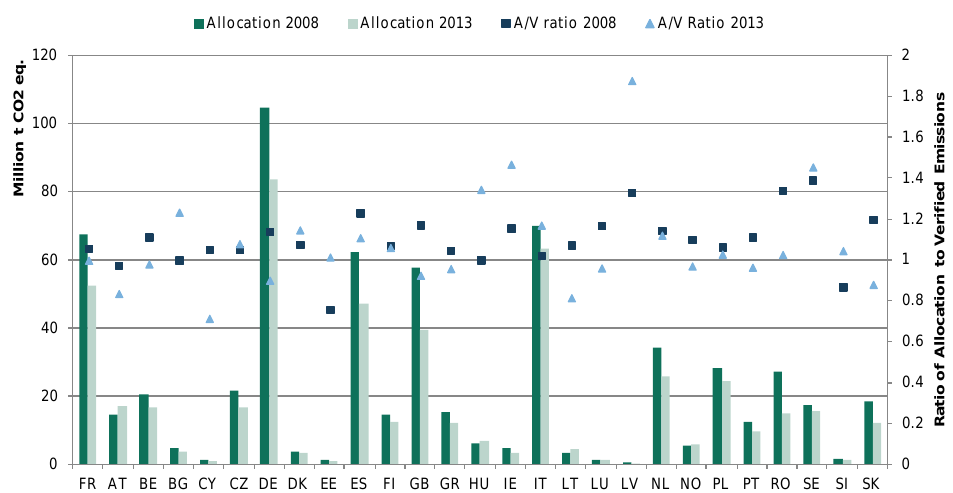
Figure 3. Allocations and Ratio of Allocations to Verified Emissions in 2008 and 2013 by Country.